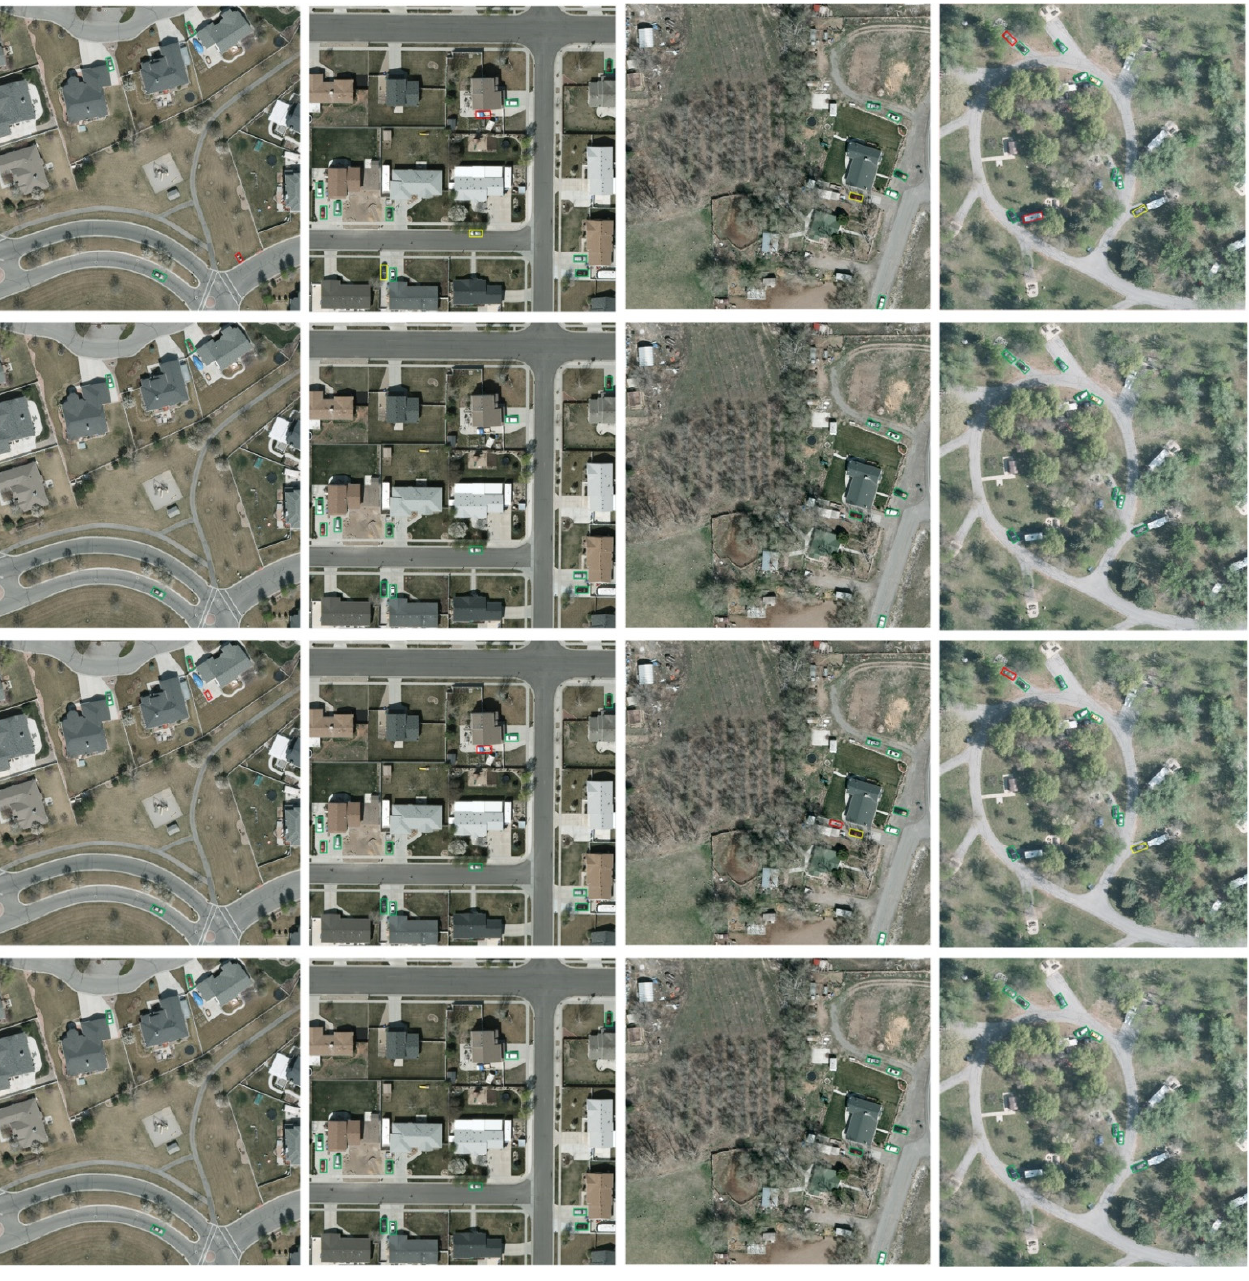
Figure 6. Visualization of the ablation study. Green, red, and yellow denote the correct, false, and missing detection results, respectively. (First row) Detection results of baseline model. (Second row) Detection results of baseline model with AFFN. Detection results of baseline model with AWLF. (Last row) Detection results of baseline model with AFFN and AWLF. Best viewed in zoomed-in view. Table 4. Results of ablation study. Experiment was implemented on VEDAI data set.